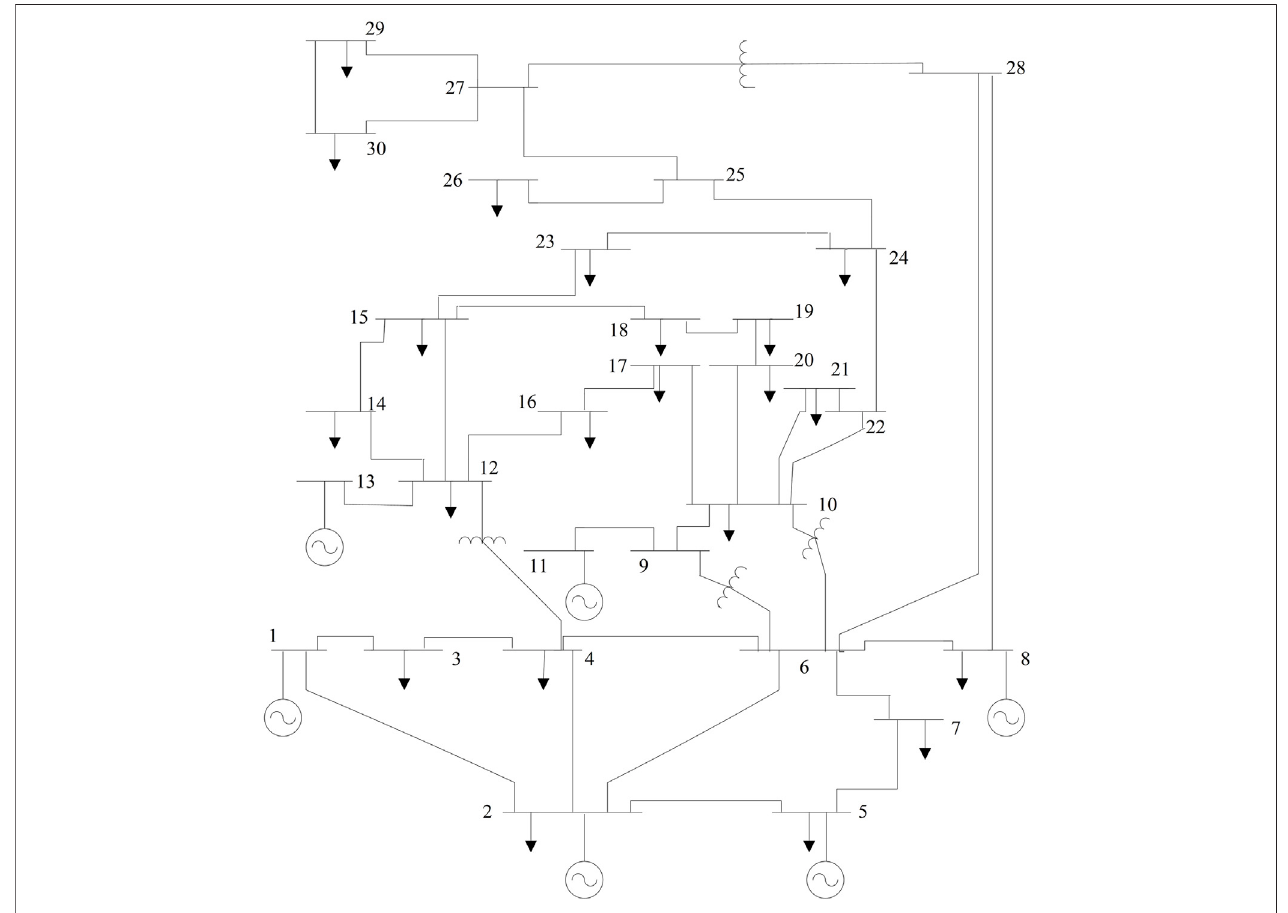
FIGURE 1 | Single line diagram of IEEE 30-bus test